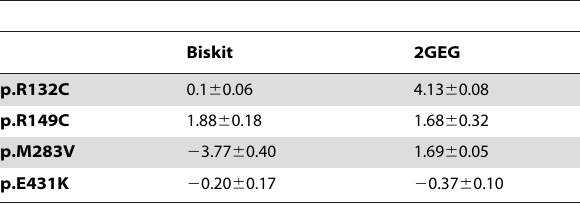
Table 2. Stability effects for the different point mutations